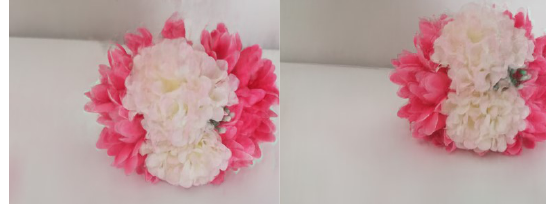
Figure 4 . Images of two novel views generated by NeRF trained using the “flower” dataset.